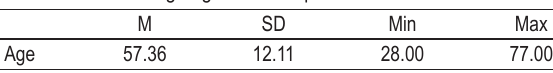
TABLE 2. The average age of the respondents